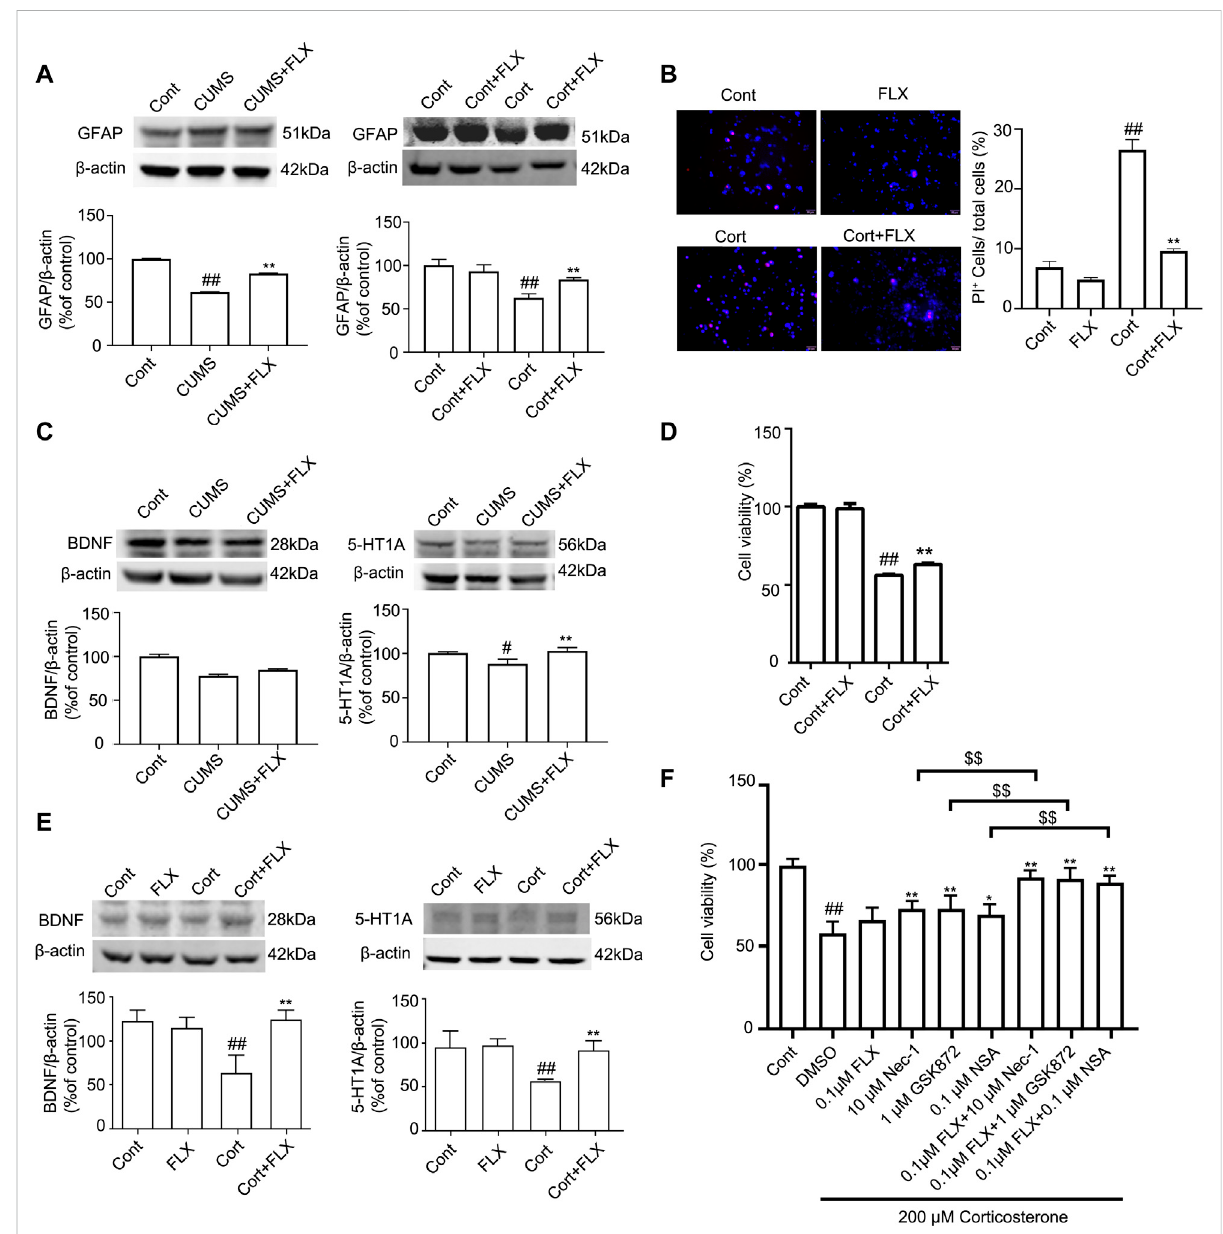
FLXtreatmentpreventsdepression-inducedreductionofastrocytesandincreasesthelevelofGFAPprotein invivoandinvitro. HAwasexposed to 200 μ MCort for1 h.HA wastreatedwith 1 μ MFLX during Cort treatment. Themice weretreated with CUMSfor 5 weeks, andFLX (10 mg/kg)was administered intraperitoneally every day during CUMS treatment. (A) Representative Western blotting images of GFAP in the mouse hippocampus andHAcells. β -actinproteinwasusedasaloadingcontrol.Dataaremean± SD , n =3.## p < 0.01vs.Cont.group,** p < 0.01vs.CUMS.groupor Cort. group. Statistical analysis was carried out with one-way ANOVA followed by Tukey ’ s test . (B) HA necrosis was assessed with propidium iodide (PI) and Hoechst staining (PI: red; Hoechst: blue). Mean ± SD , n = 3. ## p < 0.01 vs. Cont. group, ** p < 0.01 vs. Cort. group. Statistical analysis was carried out with one-way ANOVA followed by Tukey ’ s test (C and E) Representative Western blotting images of BDNF and 5-HT1A in the mouse hippocampusandHAcells. β -actinwasusedasaloadingcontrol.Mean± SD , n =3.# p < 0.05,## p < 0.01vs.Cont.group,** p < 0.01 vs. CUMS.group or Cort. group. Statistical analysis was carried out with one-way ANOVA followed by Tukey ’ s test. (D) CCK-8 assays were used to measure cell viability.Mean± SD , n =6.## p < 0.01 vs. Cont.group,** p < 0.01vs.Cort.group.Statisticalanalysiswascarriedoutwithone-way ANOVA followedby Tukey ’ stest. (F) Thecombinedadministrationoflow-doseFLXandnecroptotickinaseinhibitorsfurtherincreasedcellviabilityinCort-treatedHA.HA cells were exposed to 200 μ M Cort for 1 h. HA cells were treated with 0.1 μ M FLX, 10 μ M Nec1, 1 μ M GSK872 and 0.1 μ M NSA alone or 0.1 μ M FLX cotreated with 10 μ M Nec1, 1 μ MGSK-872or 0.1 μ M NSA during Cort treatment.CCK-8assay wasused to measure thecell viability. Mean ± SD , n